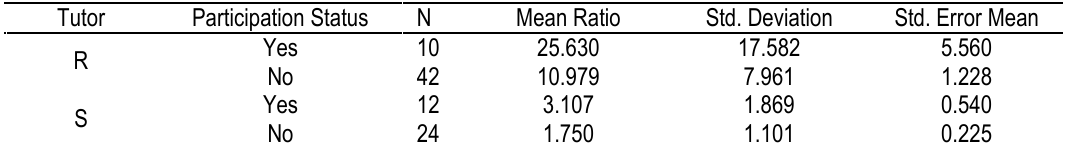
Table 3. Mean Score of the Online Participation Ratio of Learners Who Have Participated